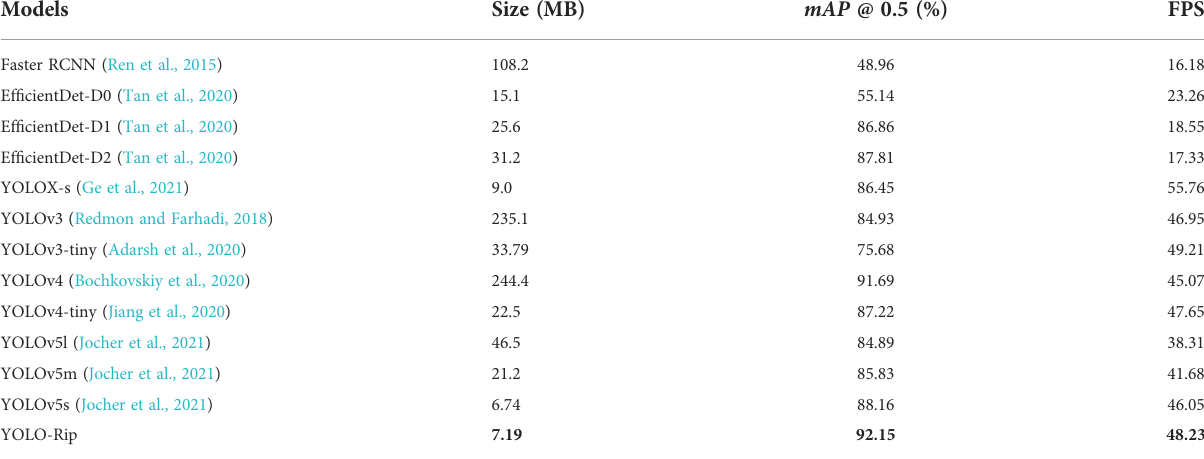
TABLE 5 Results of the number of parameters and mAP values on the training dataset of various models. Models